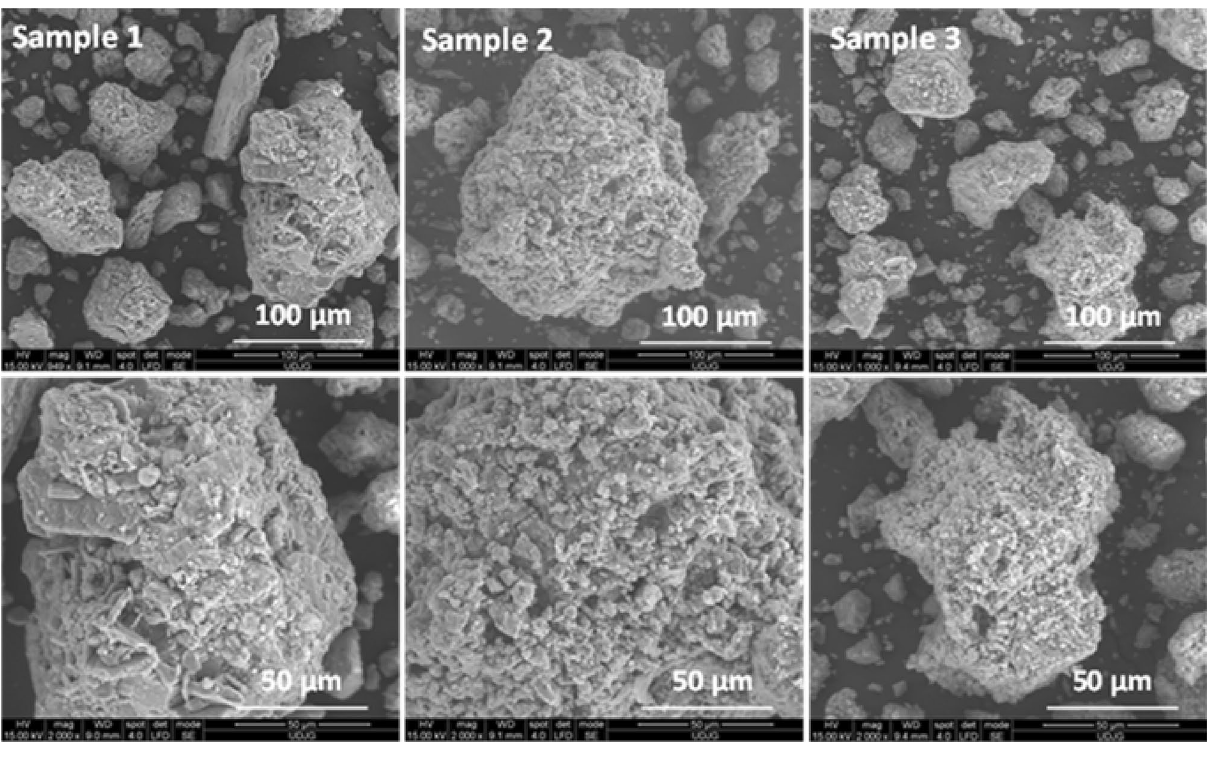
Figure 2. SEM images of slag